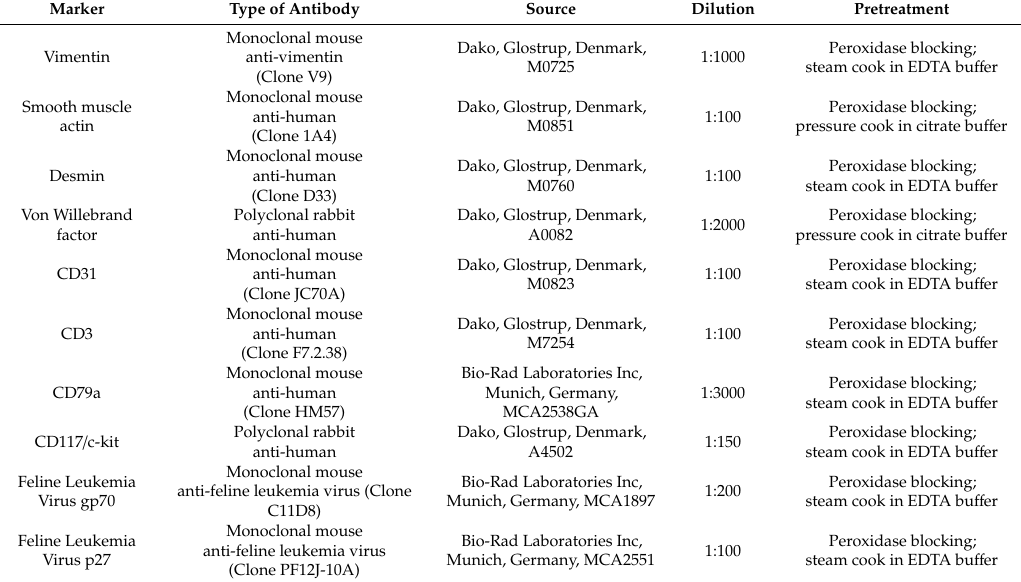
Table 1. Primary antibodies and pretreatment used in immunohistochemistry of 17 feline non-epithelial pancreatic